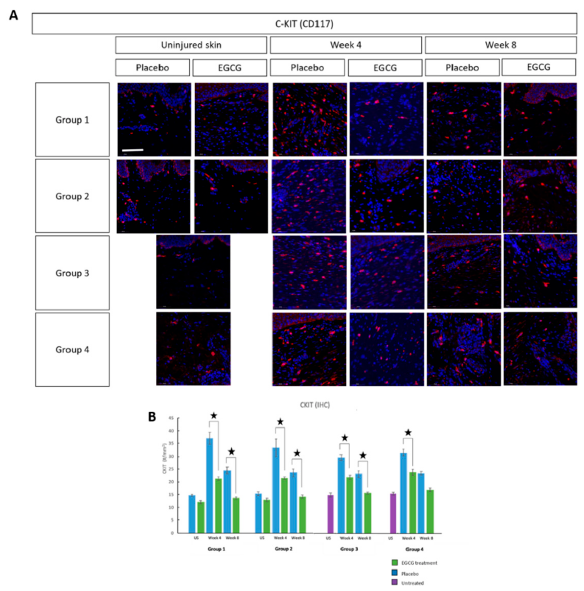
Figure 6. CKit analysis of topical epigallocatechin-3-gallate (EGCG) versus placebo. ( A ) CKit staining images showed a reduction in mast cells with EGCG compared to placebo. ( B ) Further analysis showed a significant difference between EGCG and placebo samples measurements (#/mm2) at weeks 4 and 8 ( p < 0.01) and between the groups at week 4 (Anova p = 0.01). The greatest difference was in Group 1 compared to Group 3 ( p = 0.02) and Group 4 ( p = 0.02). Significance: ★ p ≤ 0.01. Error bars: mean ± SD. Scale bars = 50 μ m. (DAPI = blue, CKit = red).